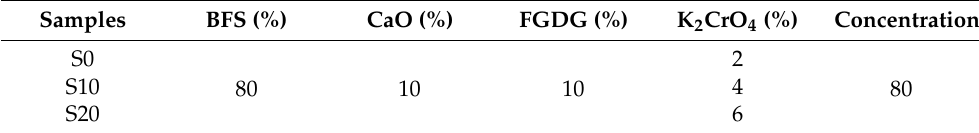
Table 1. The samples investigated for solidification mechanism of Cr in ettringite.